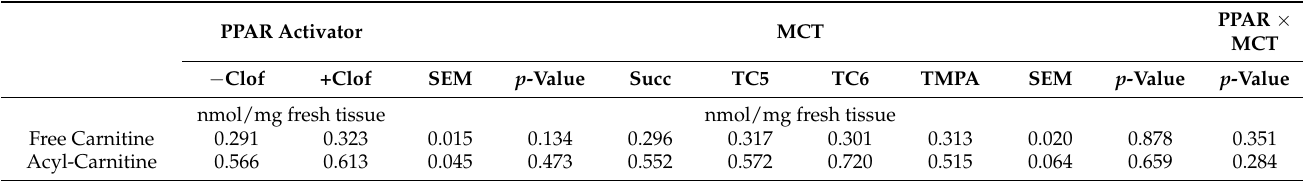
Table 3. The effect of clofibrate and MCTs on intestinal